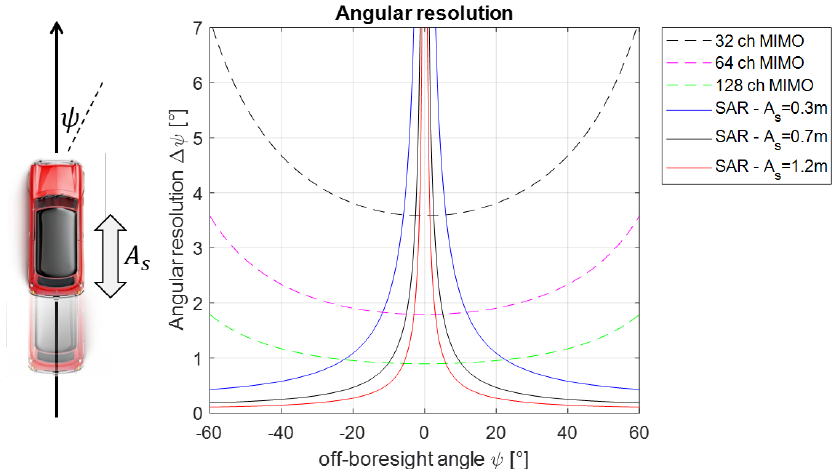
Figure 2. Angular resolution as a function of the off-boresight angle. Black dashed lines: 77 GHz MIMO radar with as 32, 64, 128 channels. Colored continuous lines: 77 GHz SAR operating at a synthetic aperture ranging from 0.3 to 1.2 m.